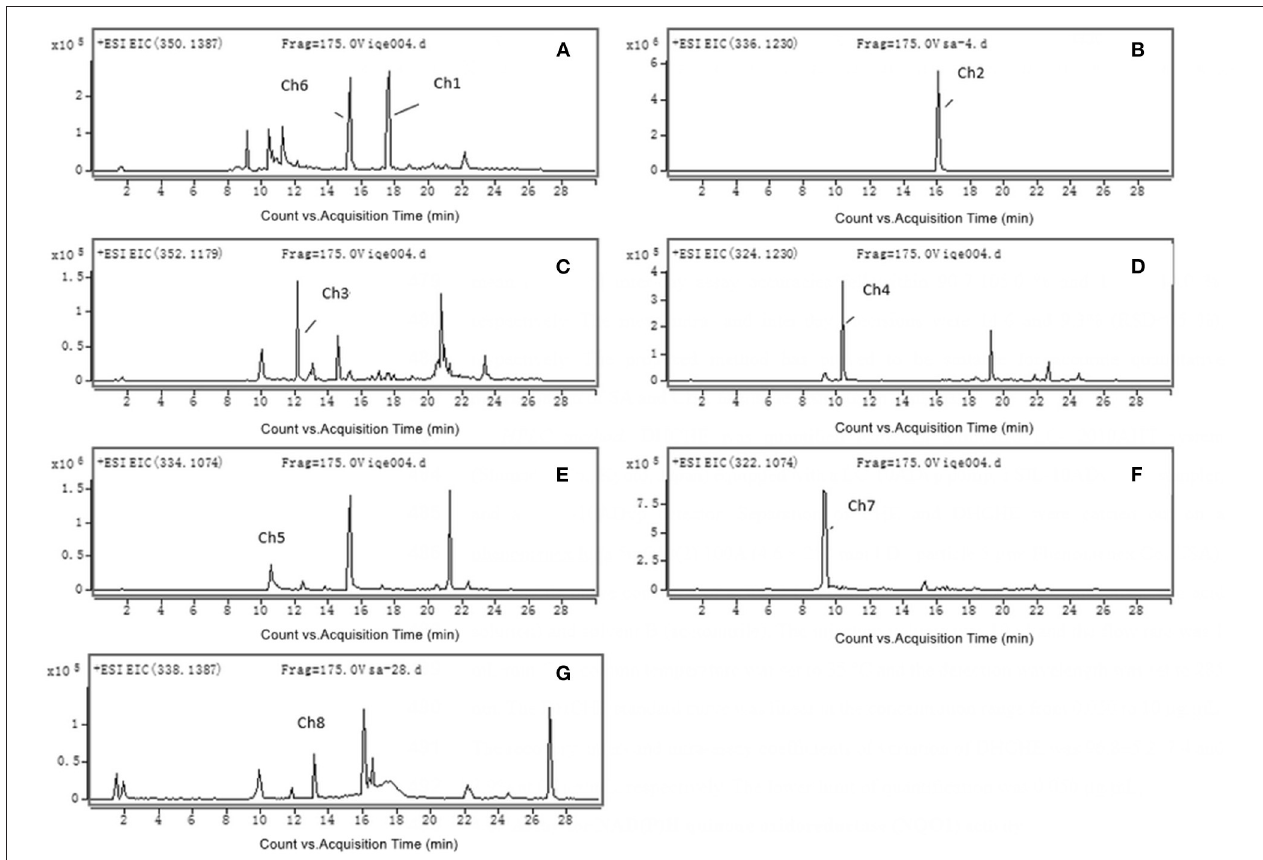
FIGURE 1 | Accurate MS mass spectra chelerythrine metabolites in rat liver S9: (A) Ch1 ( m/z 350); (B) Ch2 ( m/z 336) and Ch6 ( m/z 350); (C) Ch3 ( m/z 352); (D) Ch4 ( m/z 324); (E) Ch5 ( m/z 334); (F) Ch7 ( m/z 322); (G) Ch8 ( m/z